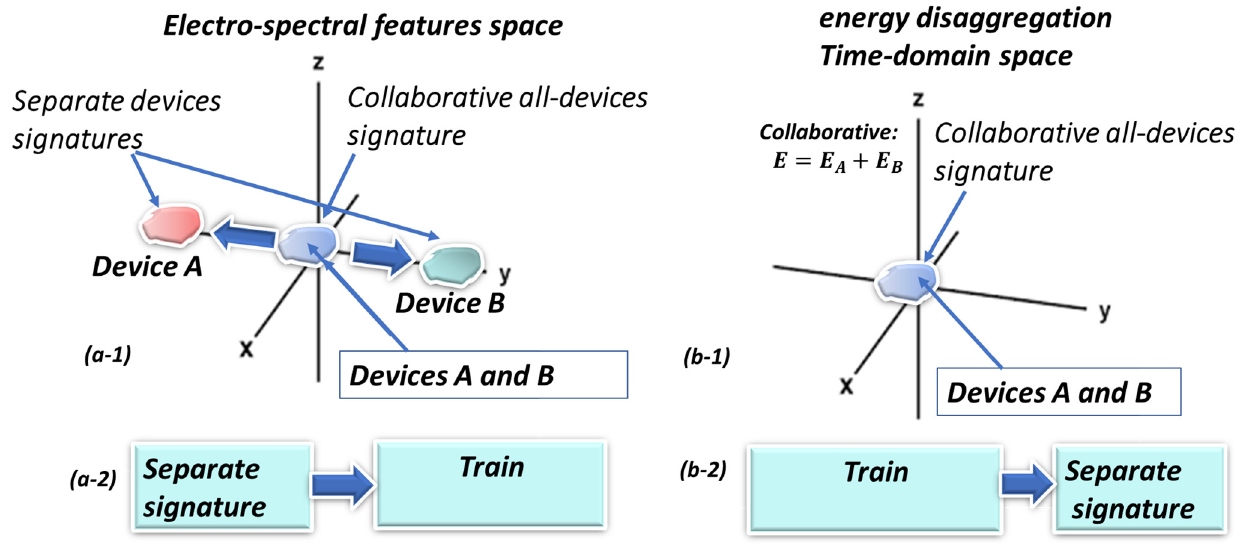
Figure 2. ( a-1 ) High order electro-spectral dimensional space if each axis is informative (orthogonal) and is potentially splitting the separated signatures of devices A, B from the collaborative signature ( A and B) at “the origin of axes” prior to the clustering/classifier AI module operation. ( a-2 ) The proposed algorithm initially separates the signatures of devices A, B in electro-spectral space and then trains them. Classical NILM algorithms usually work in the time-domain: ( b-1 ) They observe “collaborative” device ( A and B ) signatures. ( b-2 ) They initially train them and then learn to disaggregate the devices.